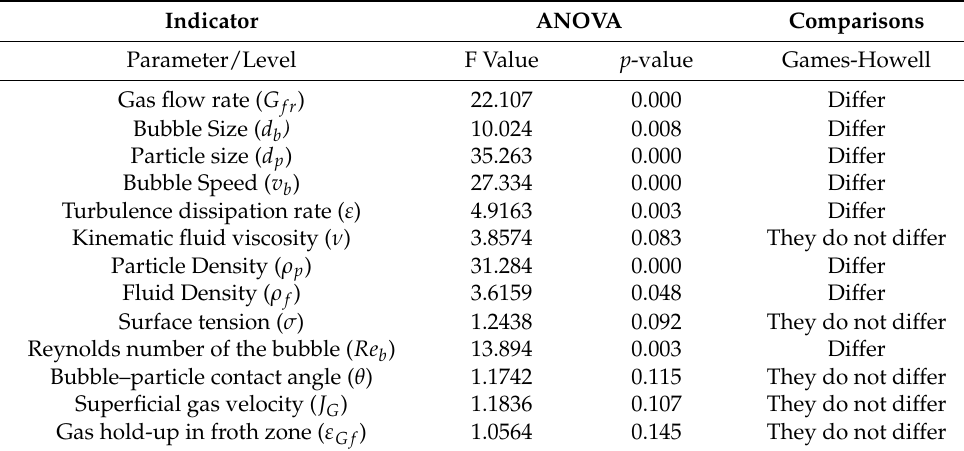
Table 3. ANOVA of recovery distributions of the rougher cell for low, medium and high levels of independent